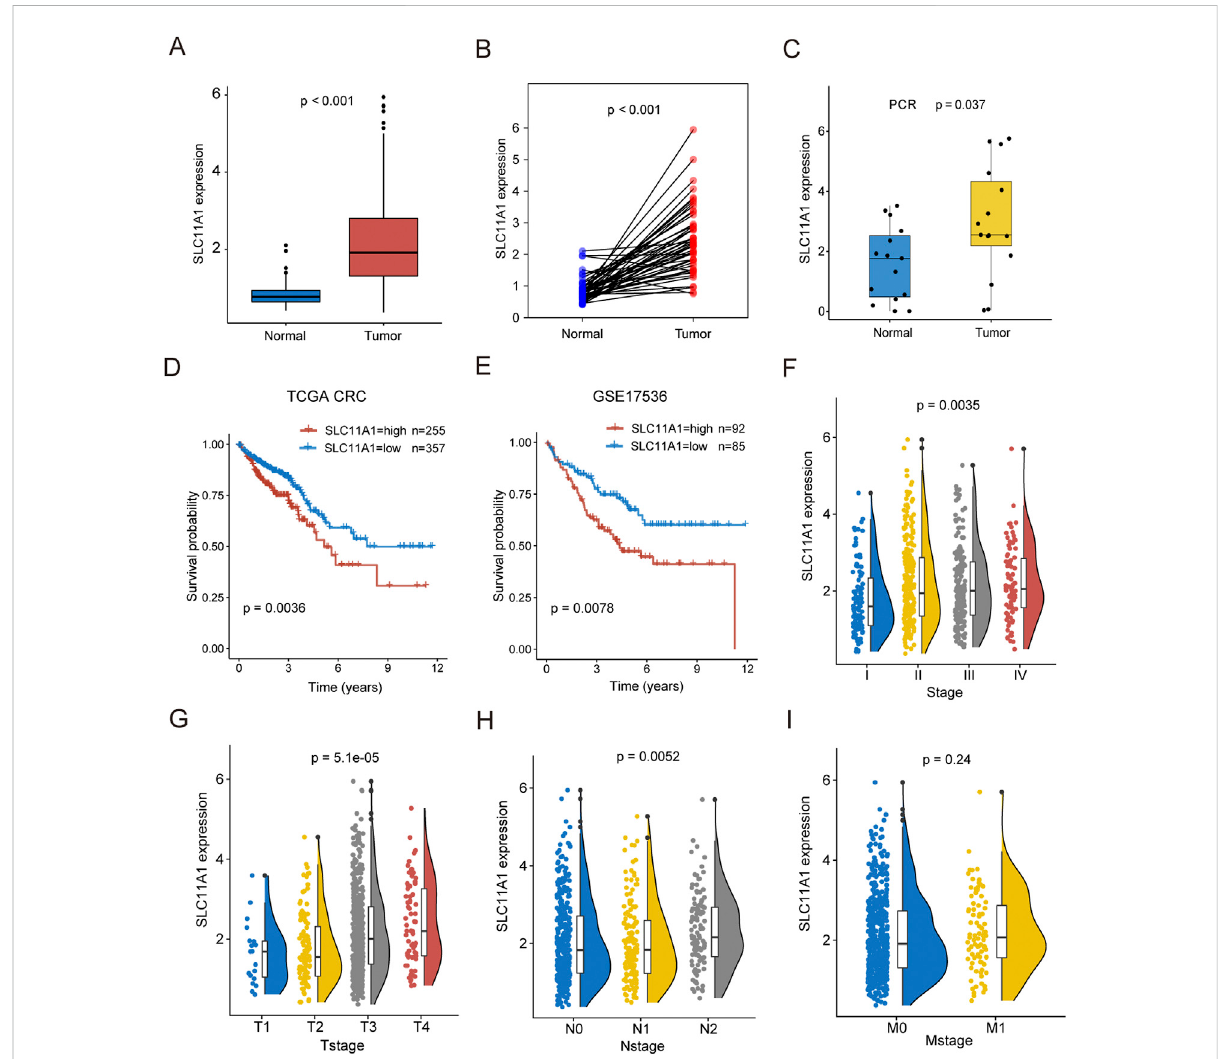
FIGURE 3 HighexpressionofSLC11A1indicatedpoorprognosisofCRCpatients. (A) ExpressiondifferencesofSLC11A1betweenCRCandadjacentnormal samples. (B) Expression differences of SLC11A1 between paired CRC and adjacent normal samples. (C) RTq-PCR demonstrated that the high expression of SLC11A1 in CRC. (D,E) KM curves showed different outcomes of overall survival between high- and low-SLC11A1 groups by using TCGA-CRCandGSE17536. (F – I) TheassociationsbetweenSLC11A1andclinicopathologicalstages(Stage,Tstage,NstageandMstage).ns, p ≥ 0.05; *, p < 0.05; ** p < 0.01; *** p < 0.001. Statistical difference of two groups was compared by the Wilcoxon test and statistical difference of four groups was compared by the Kruskal – Wallis